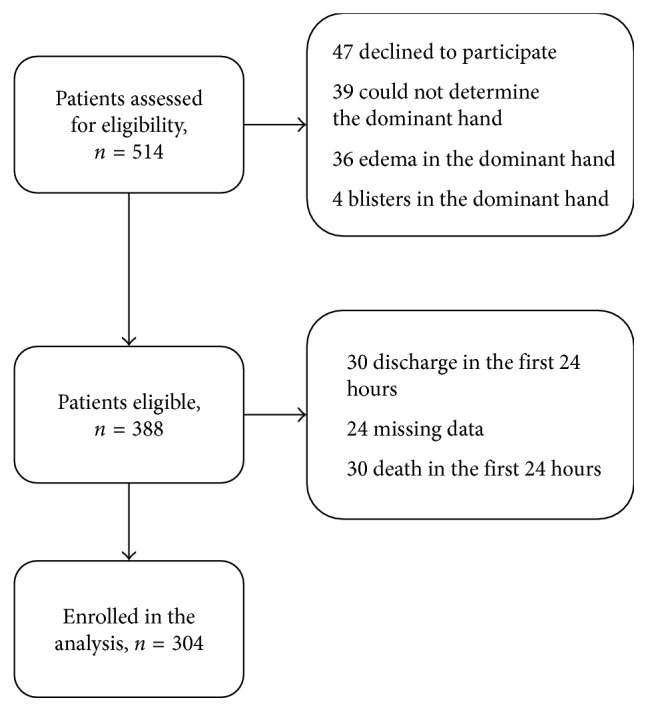
Flowchart of patients.